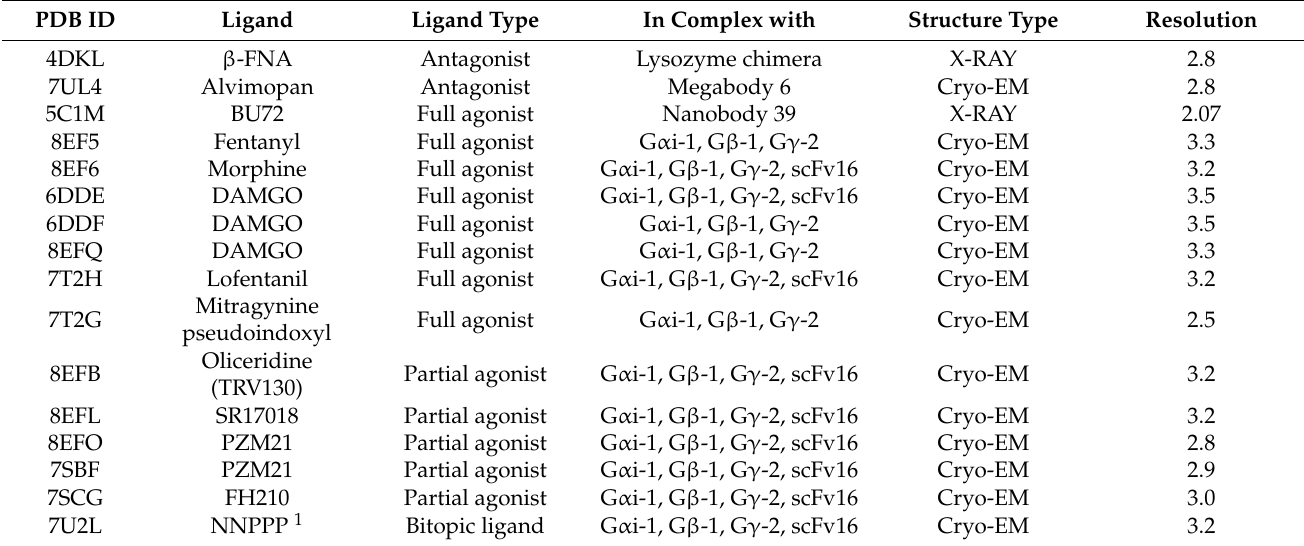
Table 2. Available structures of µ opioid receptor.